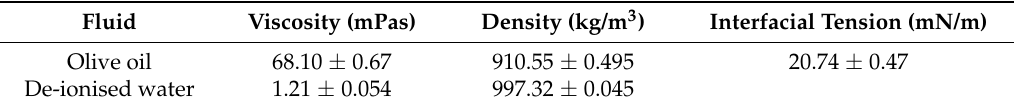
Table 1. Physical properties of